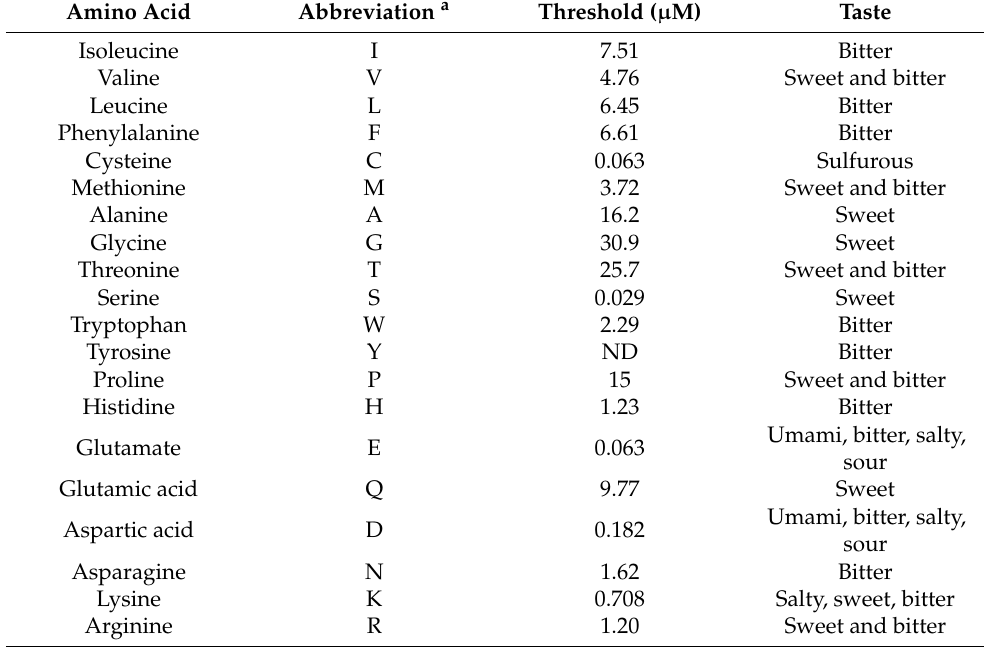
Table 1. L-amino acid tastes listed by amino acid